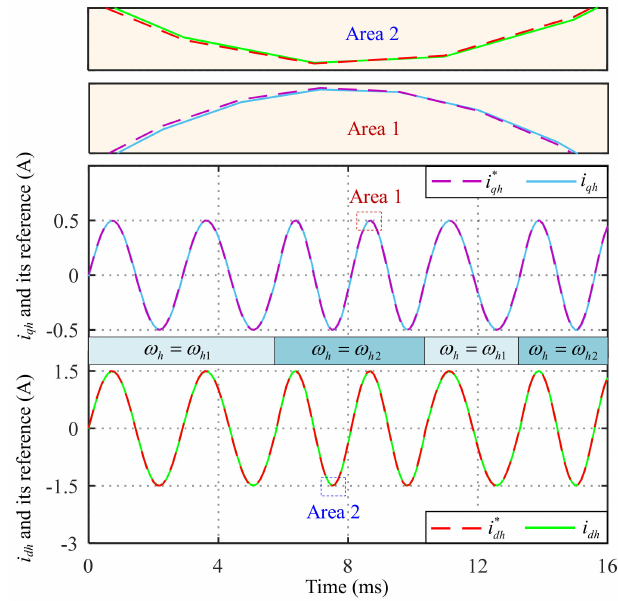
Figure 8. Results of the performance of the PRFS sinusoidal current control.